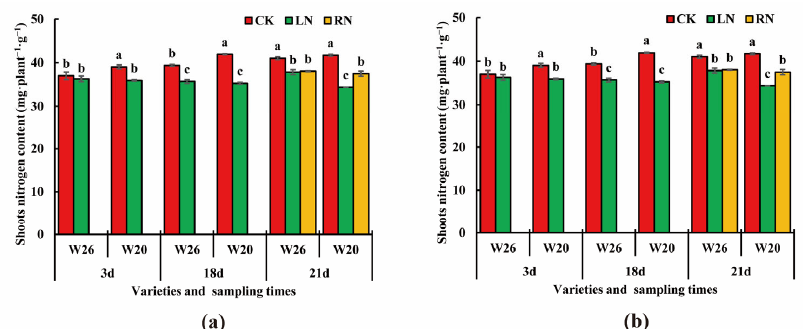
Figure 3. Nitrogen content at the three time points under different nitrogen treatments. CK represents normal nitrogen, LN represents low nitrogen, and RN represents nitrogen resupply after low nitrogen stress. ( a ) Nitrogen content of shoots; ( b ) nitrogen content of roots. The small letters represent the significant difference at the same time ( p < 0.05).